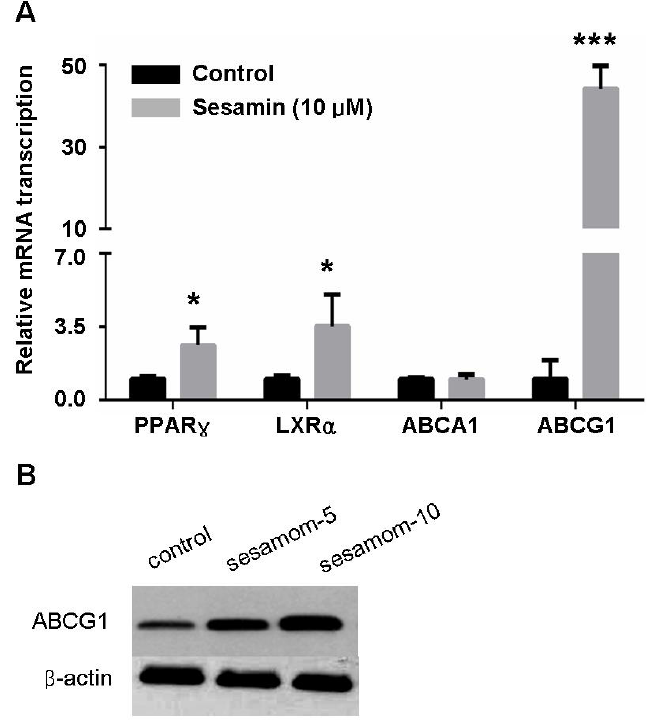
Figure 3. Sesamin increases expression of PPAR γ , LXR α and ABCG1 in RAW264.7 macrophages. ( A ) Realtime PCR analysis for PPAR γ , LXR α , ABCA1 and ABCG1. ( B ) Western blot for ABCG1. Values represent mean ± SD. Results are representative of three different experiments. * p < 0.05, *** p < 0.001 versus control